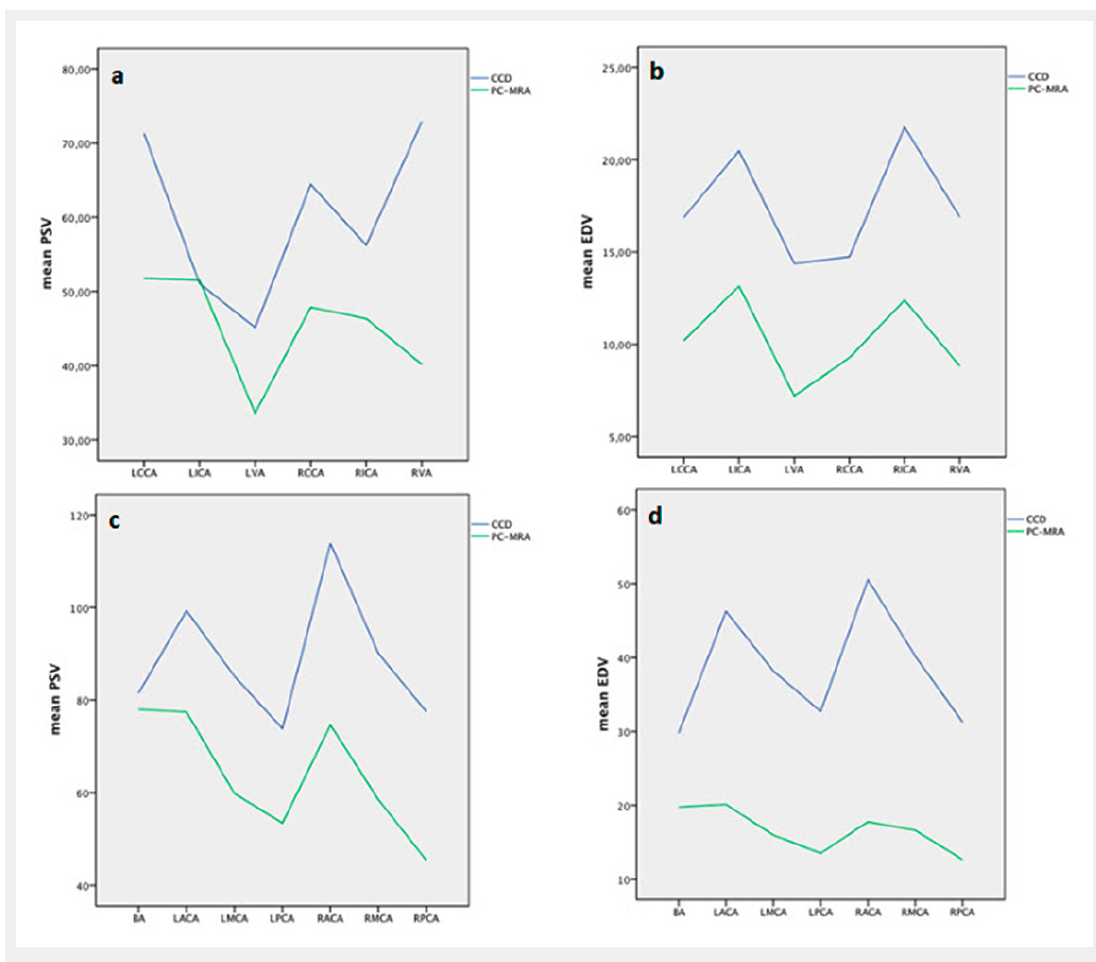
Figure 2 Mean peak systolic and end diastolic velocities of colour-coded duplex (CCD) sonography and phase contrast magnetic resonance angiography (PC-MRA) of extracranial (a,b) and intracranial (c,d) arterial segments. BA = basilar artery; LACA = left anterior cerebral artery; LCCA = left common carotid artery; LICA = left internal carotid artery; LMCA = left middle cerebral artery; LPCA = left posterior cerebral artery; LVA = left vertebral artery; RACA = right anterior cerebral artery; RCCA = right common carotid artery; RICA = right internal carotid artery; RMCA = right middle cerebral artery; RPCA = right posterior cerebral artery; RVA = right vertebral